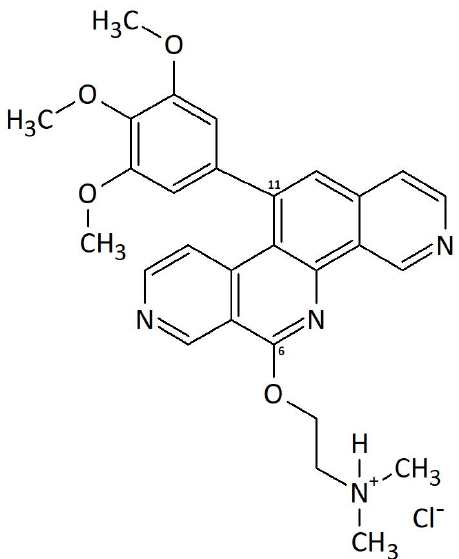
Figure 1. Chemical structure of P8-D6 (6-( N,N -dimethyl-2-aminoethoxy)-11-(3,4,5-trimethoxyphenyl)pyrido[3,4- c ][1,9]phenanthroline hydrochloride).